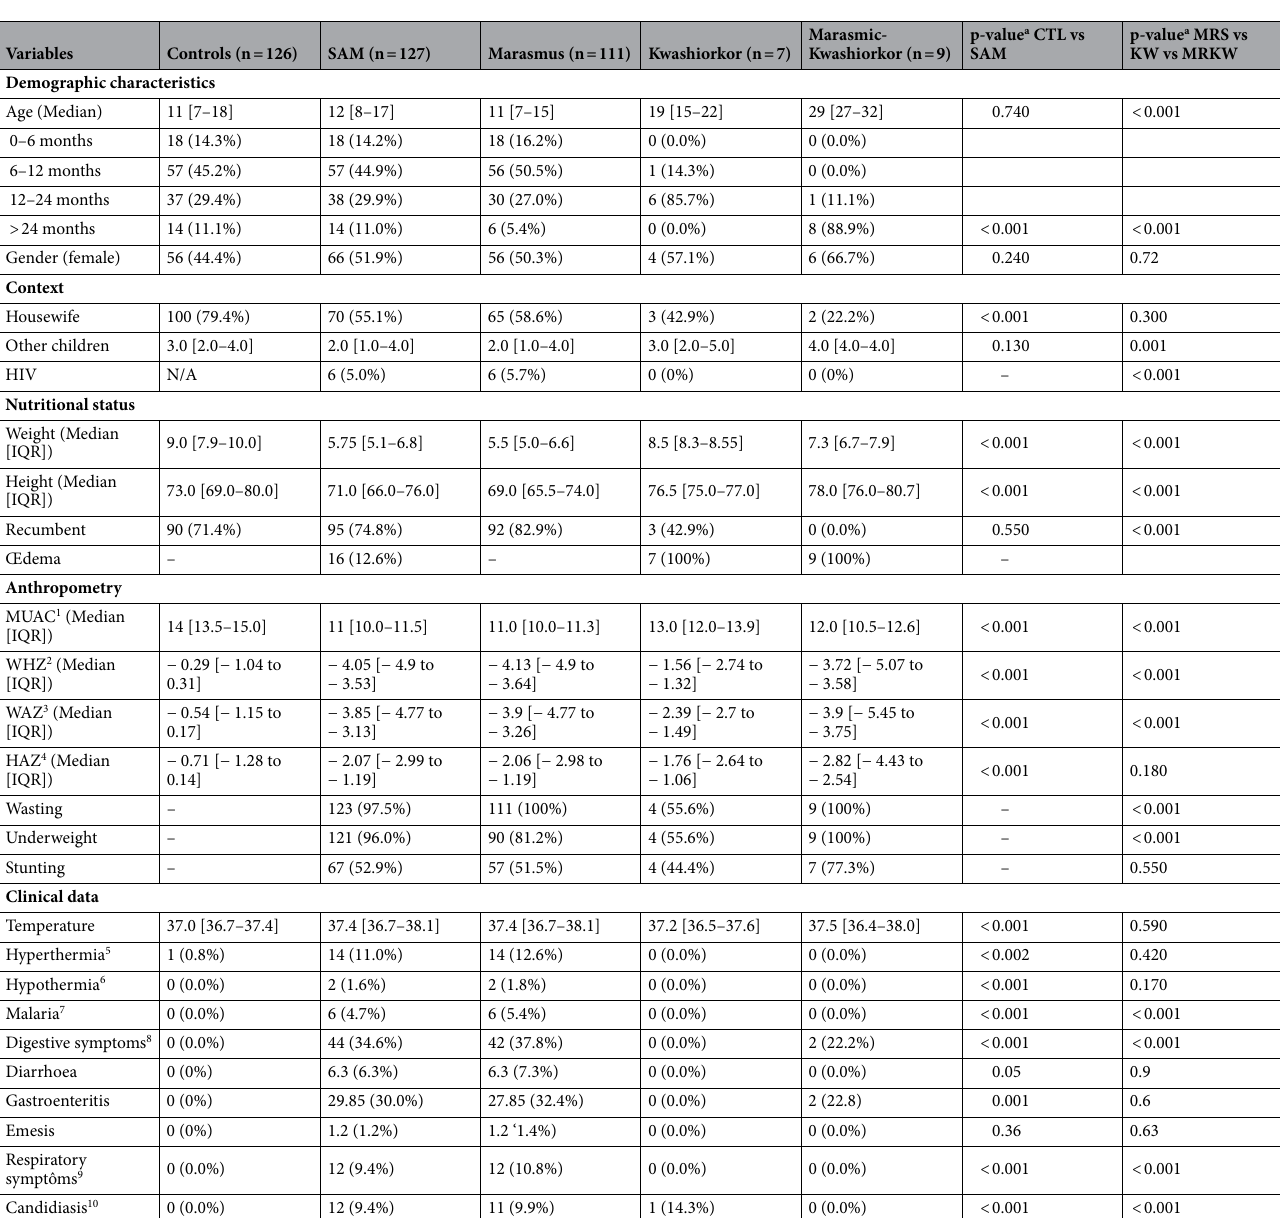
Table 1. Sociodemographic, nutritional and clinical baseline characteristics—weighted data (n = 253). SAM severe acute malnourished; CTL control children; MRS marasmus; KW kwashiorkor; MRKW